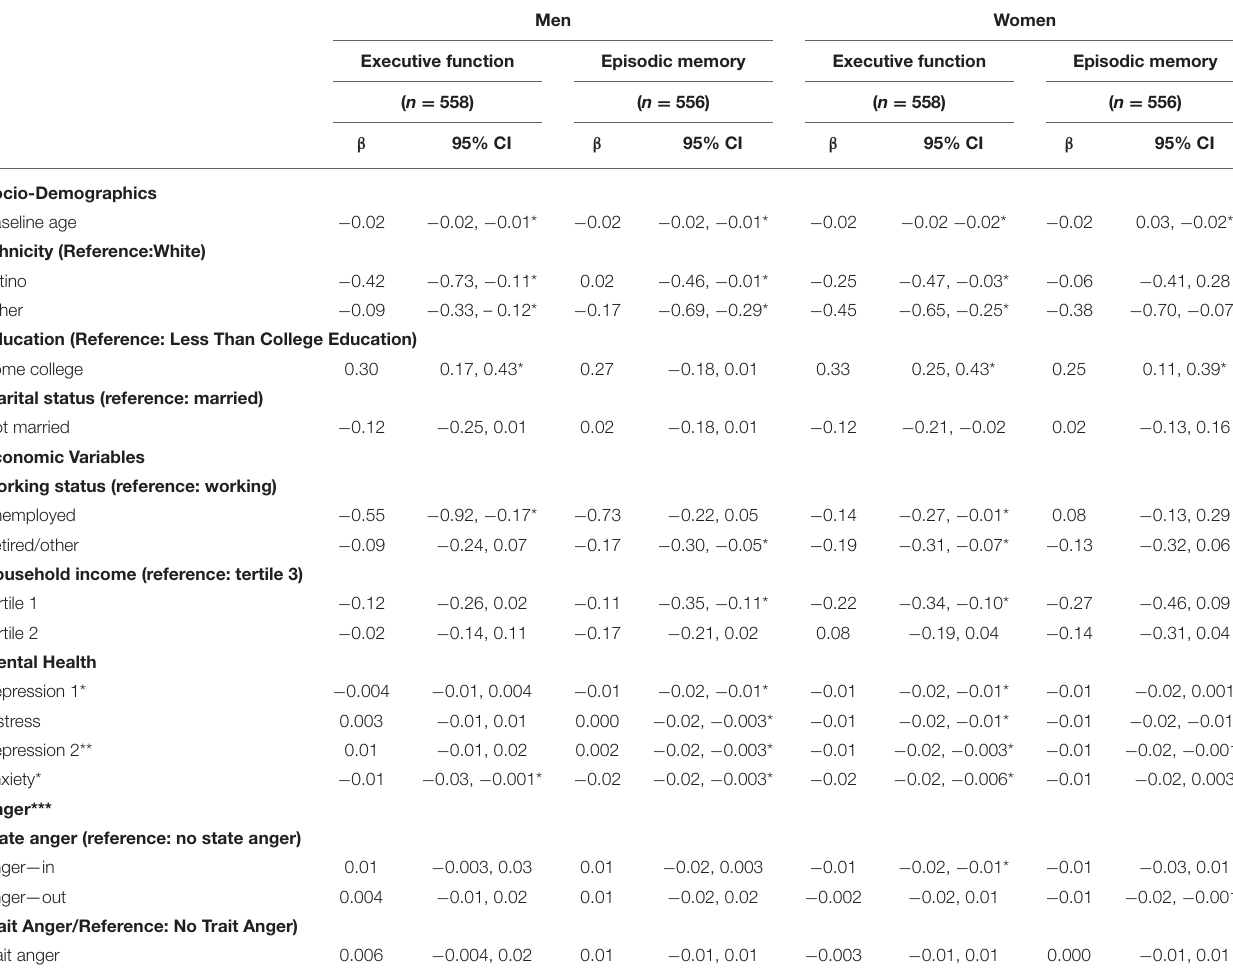
TABLE 2 | Associations of socio-demographic, work related, and mental conditions (depressive-, anxiety-, and anger symptoms) and executive function and episodic memory by gender in cross-sectional analyses.